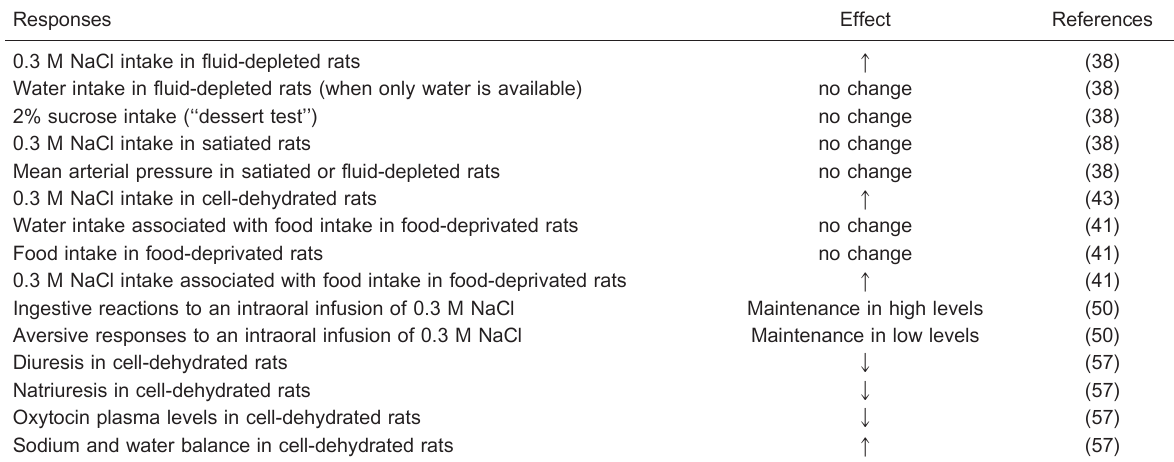
Table 1. Effects of a 2 -adrenoceptor activation in the LPBN on different ingestive, behavioral, renal and hormonal responses.